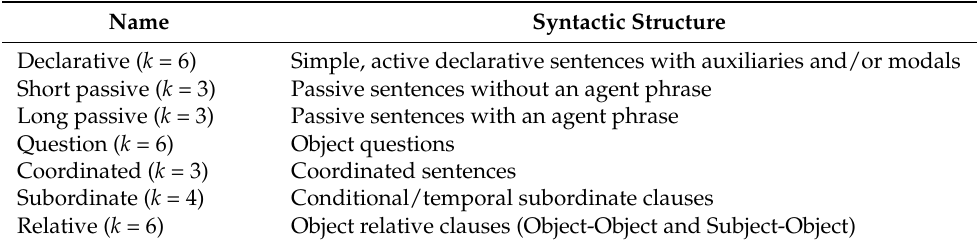
Table 1. Structures used in the English sentence repetition task